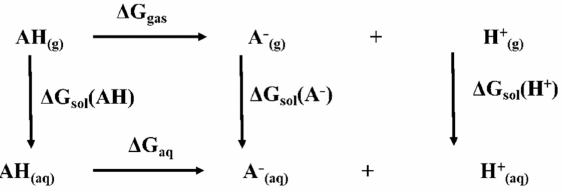
Figure 8. Scheme of the thermodynamic cycle.